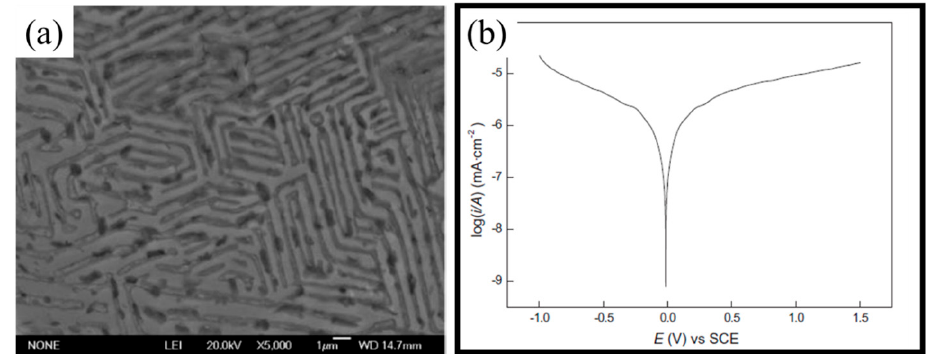
Figure 9. ( a ) Microstructure of AlCoCrFeNi-Cu alloy obtained by powder-metallurgy route; ( b ) Potentiodynamic polarization curve in 1 mol/L NaCl showing corrosion potential close to 0 V with respect to saturated calomel electrode [37] (reprinted with permission from